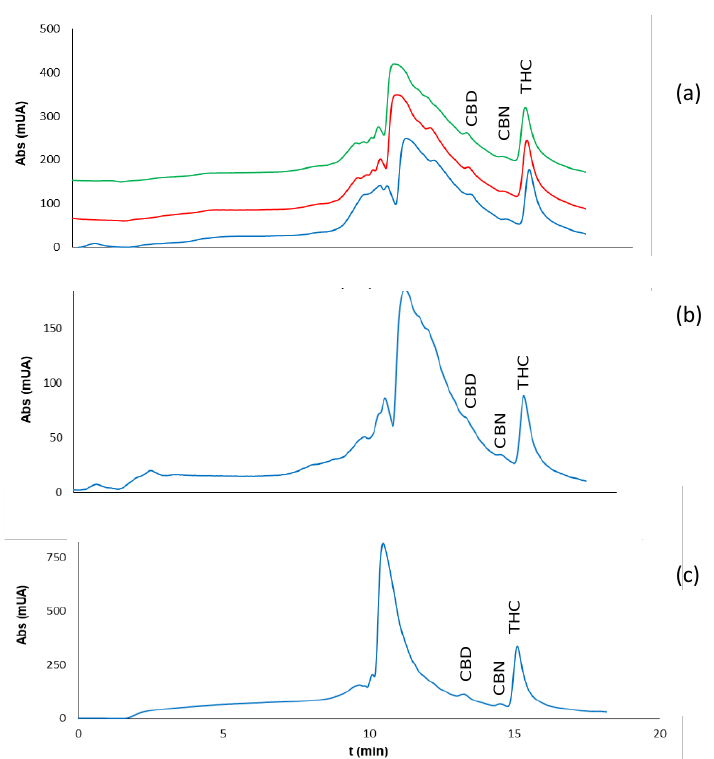
Figure 4. Chromatograms obtained for the analysis of residues of cannabis (sample M1) in: ( a ) aluminum foil, ( b ) cellulose paper, and ( c ) and skin. The sample amounts collected with the swabs were 0.27, 0.10, and 0.25 mg in ( a – c ), respectively; the extracts were diluted 1:20 with ultrapure water before the IT-SPME–nanoLC step in ( a , b ) and 1:5 in ( c ). Conditions for sampling and extraction were identical to those indicated in Section 2.3.1; conditions used for IT-SPME and chromatographic analysis are indicated in Sections 4.3 and 4.2, respectively.